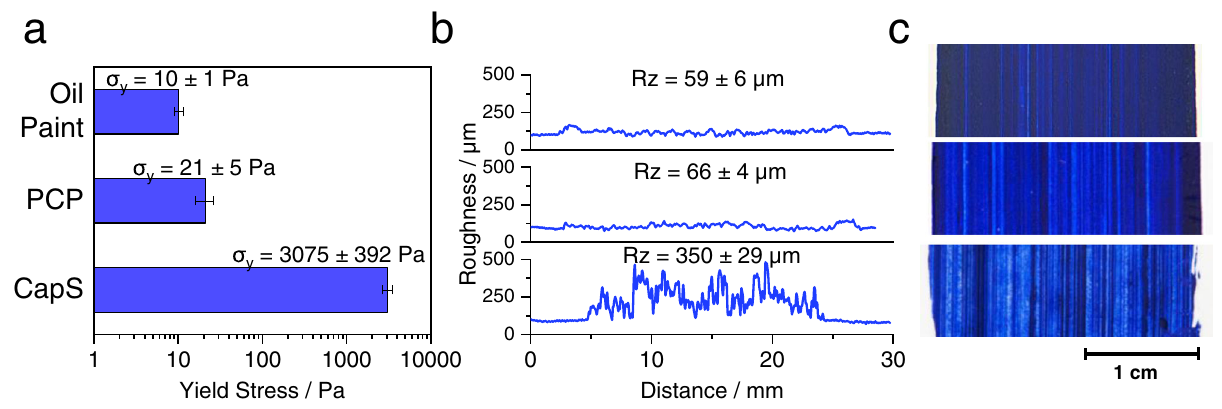
Fig. 3 | Wet paint yield stress and brushstroke pro fi le. Ultramarine paints, rela- tionship between a yield stress σ y , b roughness Rz and pro fi le of the paint brush- strokes, and c appearance of the paint layer. The paints were prepared at a solid fractionof φ =32vol%,including2vol% ofegg yolksolidsforthepaintscontaining